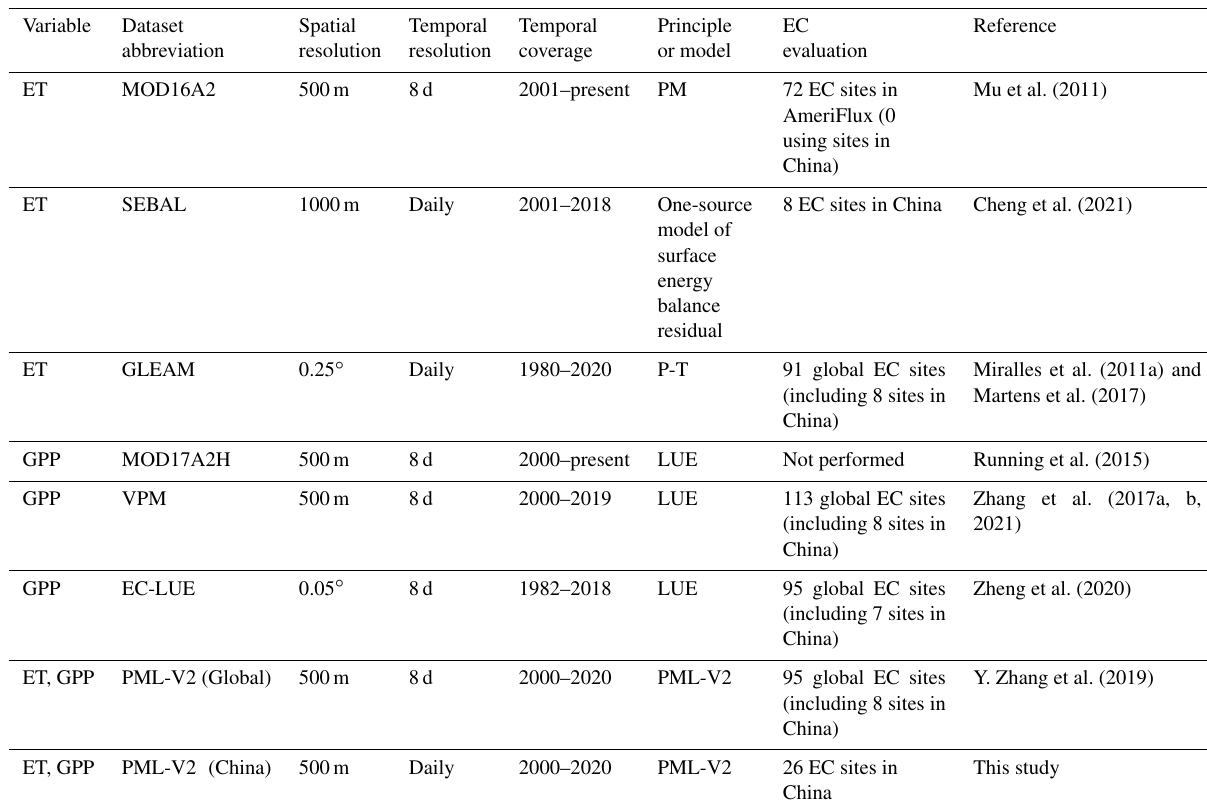
Table 1. Summary of typical ET and GPP products with high temporal and/or high spatial resolutions.